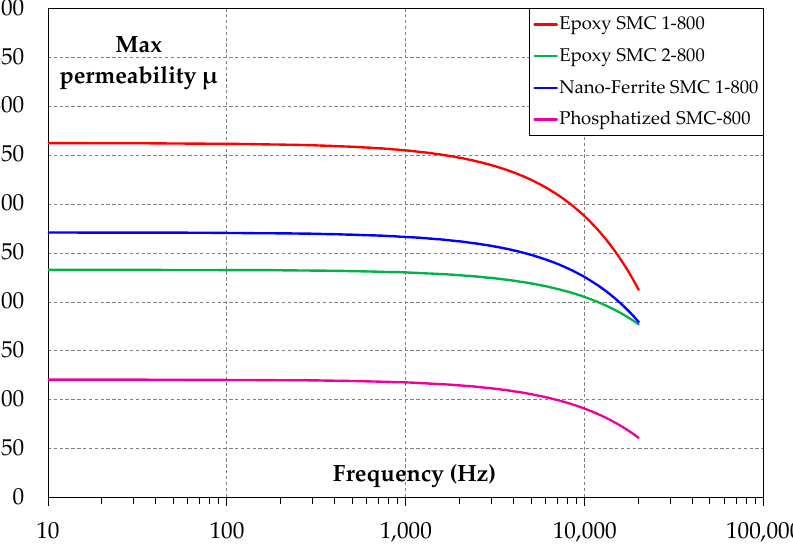
Figure 8. The specific iron losses at 0.1 T of proposed toroid samples in a frequency range of 20 kHz . Some materials obtained favorable results for the initial magnetic permeability of the proposed SMC toroid samples, as shown in Figure 9, for the real part of the initial magnetic permeability. For example, epoxy SMC 1-800 showed values around 90, while commercial material was the lowest, exhibiting a good value of about 50. A high initial magnetic permeability is generally required for audio and telecommunication applications or instrument transformers where the magnetizing current is low. Commonly, the imaginary part of initial magnetic permeability is considered null; on the other hand, Figure 10 demonstrates that some materials have considerable values, which turn into losses. The low values are obtained in the case of commercial and high-resin- content materials. From this point of view, the inductor quality factor Q is calculated through Equation (1), and the results are reported in Figure 11. Phosphatized SMC-800 showed the best Q factor at around 7000 Hz. On the other hand, epoxy SMC 2-800 had modest data in the